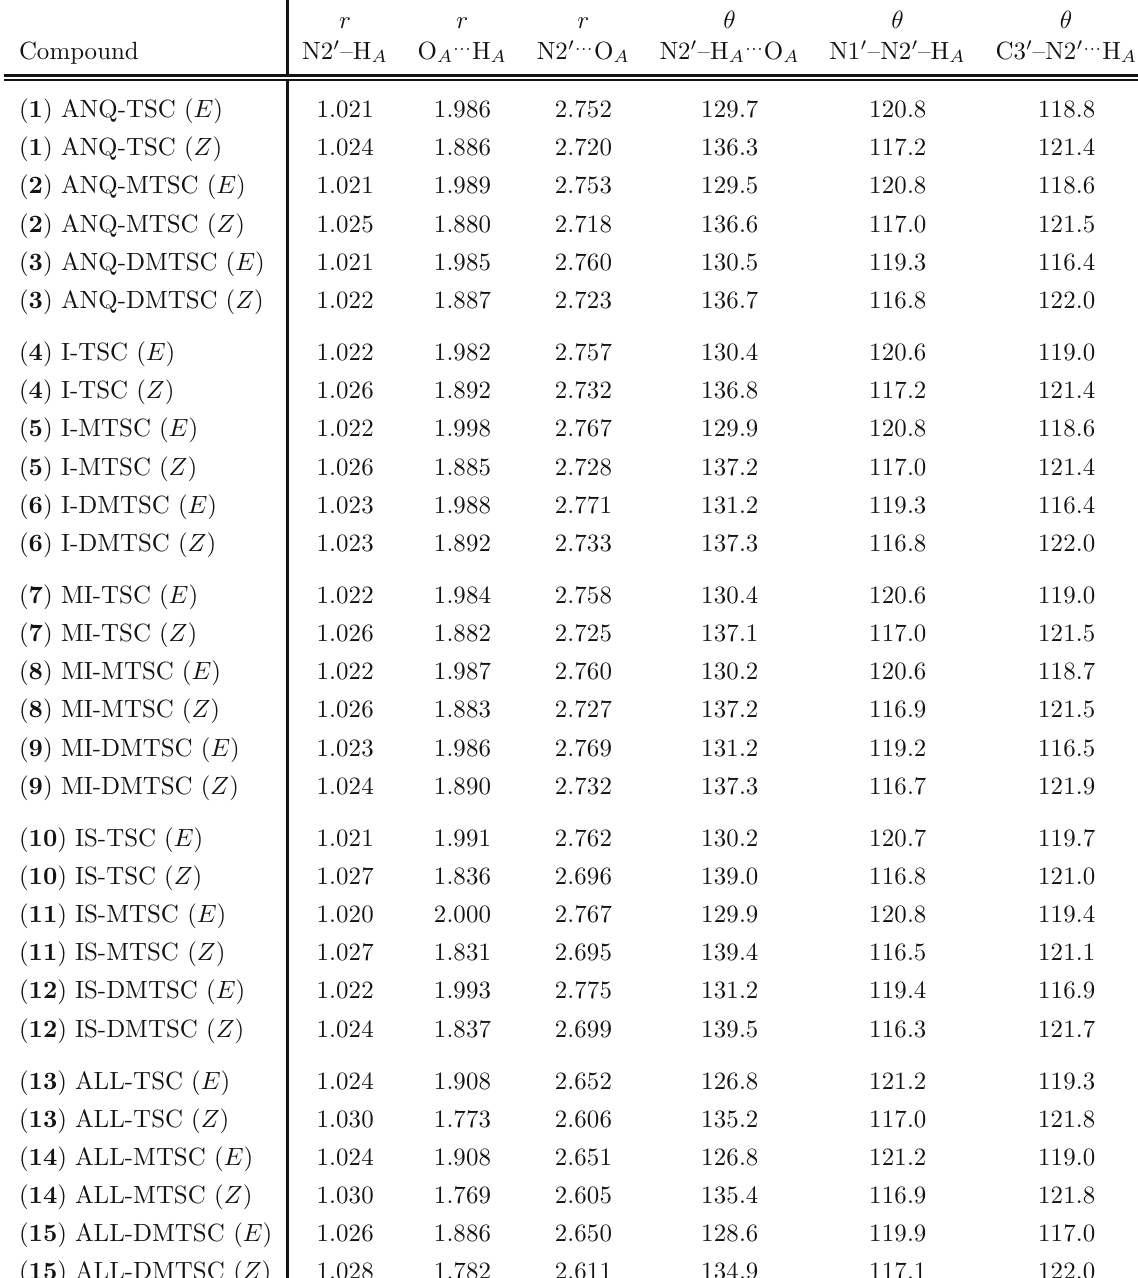
Table 1 Selected distances (A) and angles (degree) in the optimized geometries deter- mined at the mPW1PW91/6-31+G(d,p) level of theory. r r r θ θ θ Compound N2 (cid:3) –H A O A... H A N2 (cid:3) ... O